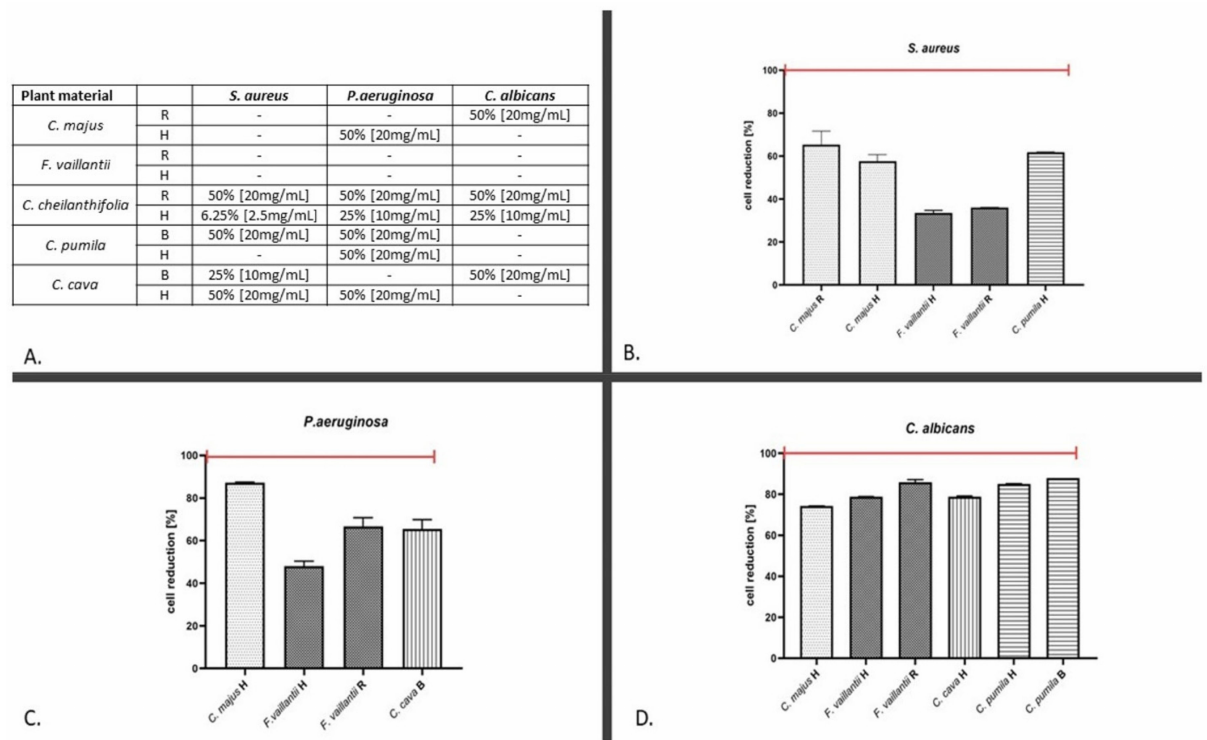
Figure 1. ( A ) Minimum inhibitory concentration (MIC (%)) of extracts against planktonic microbial cells. Dashes ( − ) indicate extracts in which the MIC values were not reached in the highest concentration (50%) of the extract applied. ( B – D ) Reduction of planktonic cell count below MIC’s threshold after the exposure to extracts, measured for S.aureus, P.aeruginosa , and C.albicans (in ( B – D ), respectively). Abbreviations: R—roots, H—herb, and